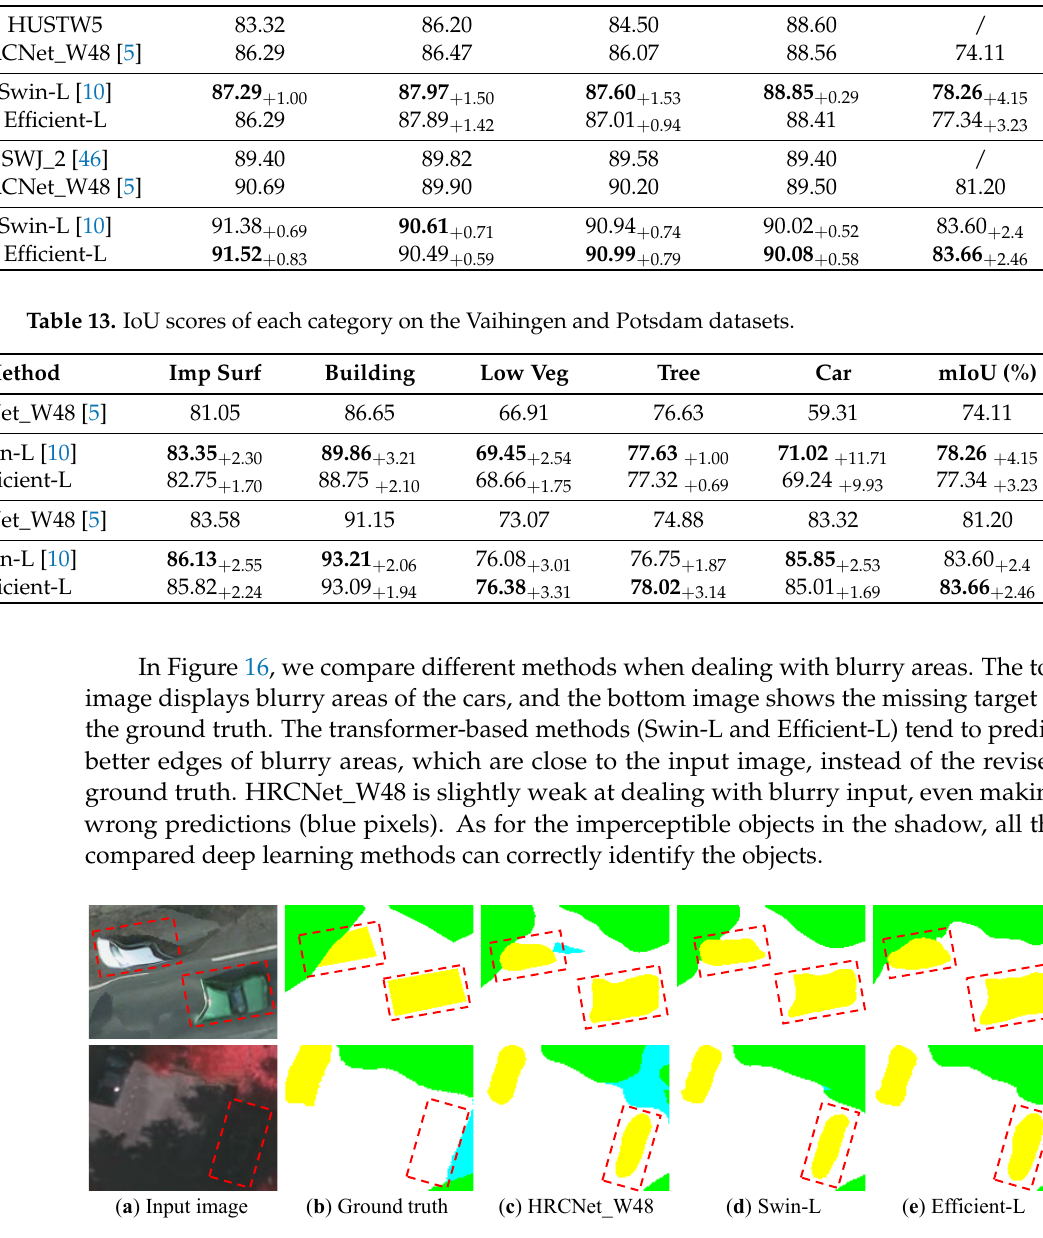
Figure 16. Comparison of the improvement on blurry